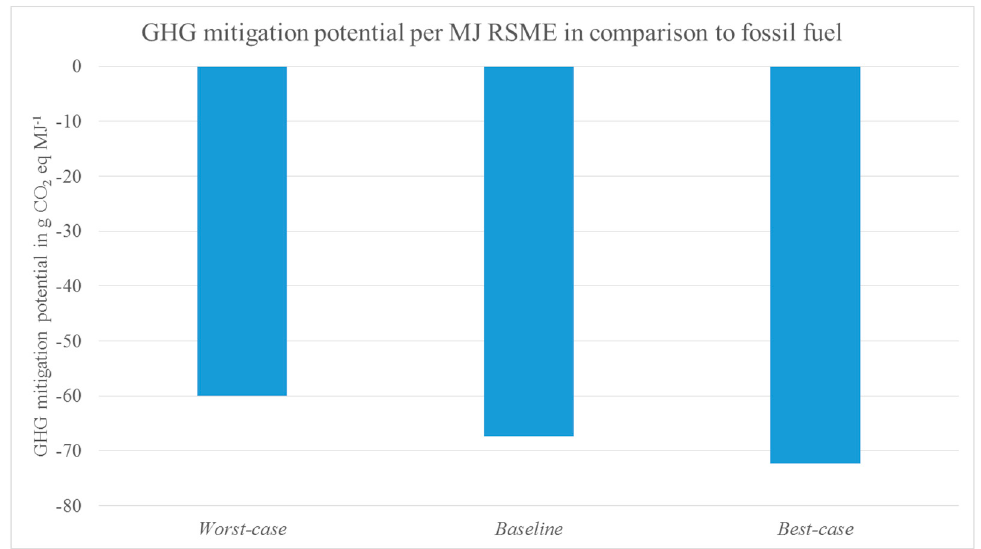
Figure 3 . GHG mitigation potential of rubber seed-based biodiesel production in g CO 2 eq. MJ − 1 RSME for the worst-case , baseline and best-case scenarios.